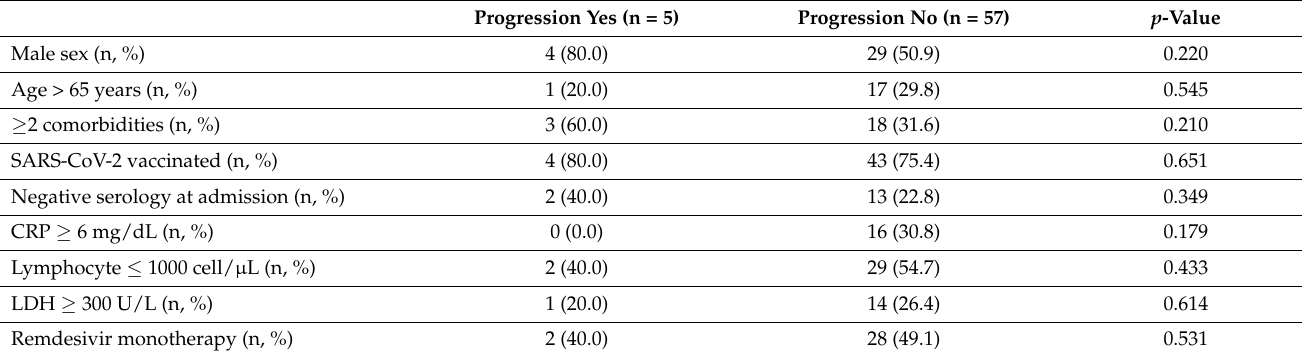
Table 2. Frequency of COVID-19 progression according to patients’ characteristics.